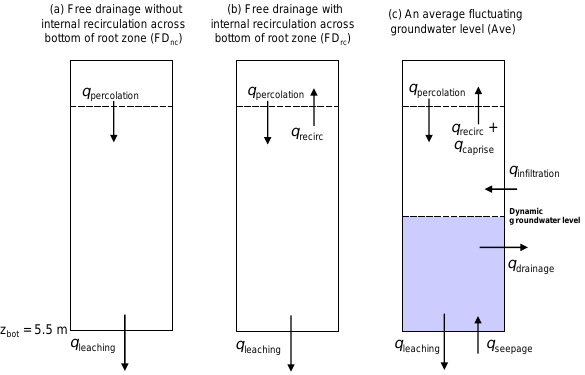
Figure 2. Schematization of three hydrological conditions: (a) free drainage without recirculation across the bottom of the root zone (FD nc ); (b) free drainage with recirculation across bottom of root zone (FDrc); (c) average fluctuating groundwater level (Ave). Con- ditions (a) and (b) have free-draining bottom boundary conditions without groundwater. Condition (a) is artificially created to explic- itly demonstrate the role of recirculating percolation resulting in up- ward flow to the root zone. Condition (b) is a common free-drainage situation which includes upward flow due to recirculating perco- lation water. Condition (c) is the natural situation in most of the Netherlands. This hydrological condition has a fluctuating ground- water level derived from a national study (Van Bakel et al., 2008). Figure 3. Five grouped soil types, based on 72 soils of the Soil